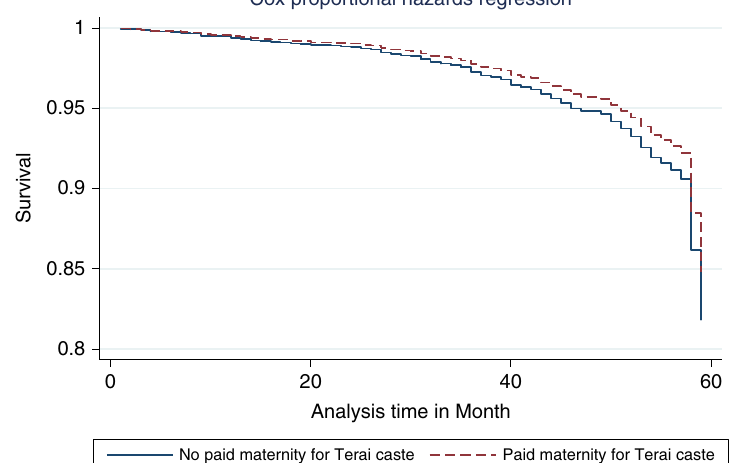
Figure 3. Predication of survival of child by caste of mother